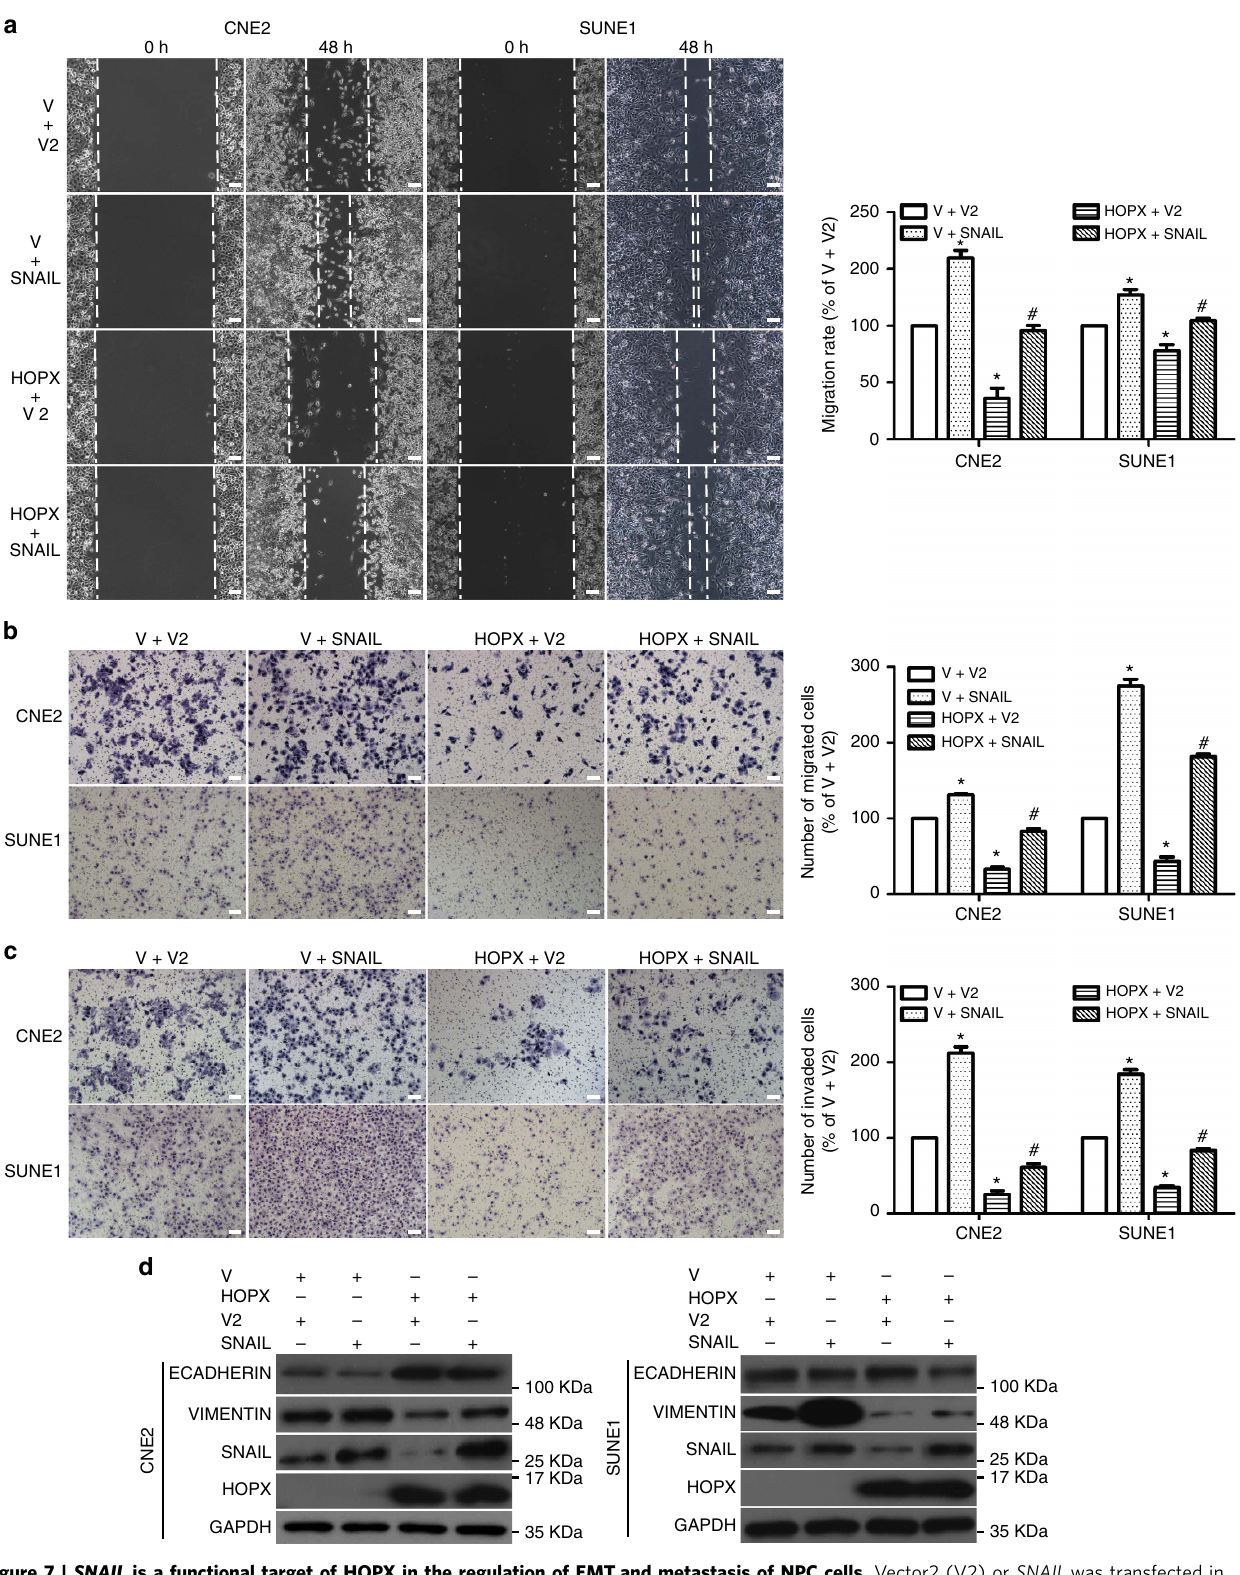
Figure 7 | SNAIL is a functional target of HOPX in the regulation of EMT and metastasis of NPC cells. Vector2 (V2) or SNAIL was transfected in CNE2 and SUNE1 cells that stably overexpressed the vector (V) or HOPX. ( a – c ) The migration and invasion abilities were measured using wound healing assays ( (cid:2) 200) ( a ) and Transwell assays ( (cid:2) 200) without ( b ) or with ( c ) Matrigel. Scale bar, 100 m m; mean ± s.d.; * P o 0.01 compared with V þ V2; # P o 0.01 compared with the HOPX þ V2; Student’s t -tests. ( d ) ECADHERIN, VIMENTIN, SNAIL, HOPX and GAPDH expression levels were measured via western blotting. These data are representative of three independent